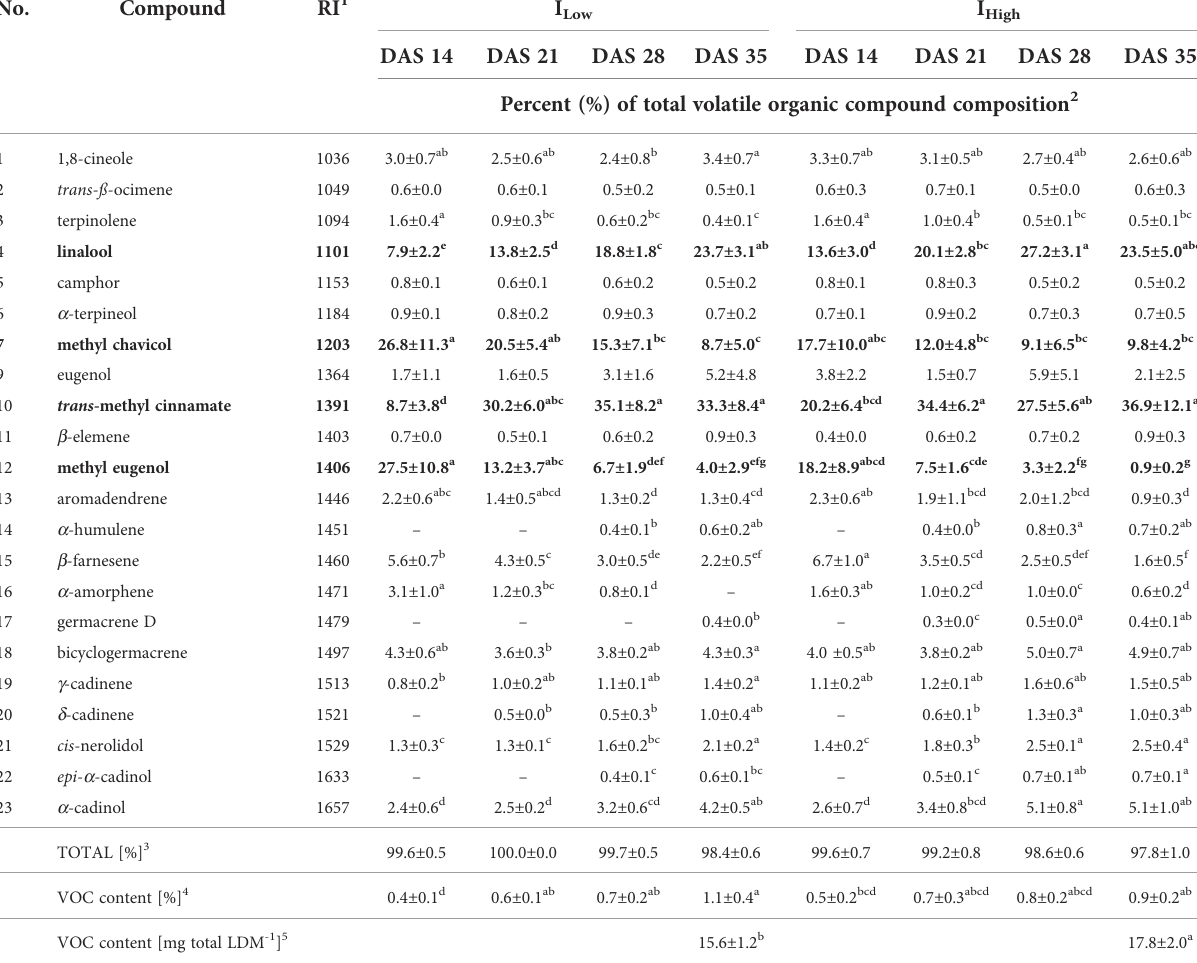
TABLE 6 Relative abundance of major volatile organic compounds identi fi ed in the leaves of O. basilicum L. cv. ‘ Cinnamon ’ as affected by LED light intensity treatments over